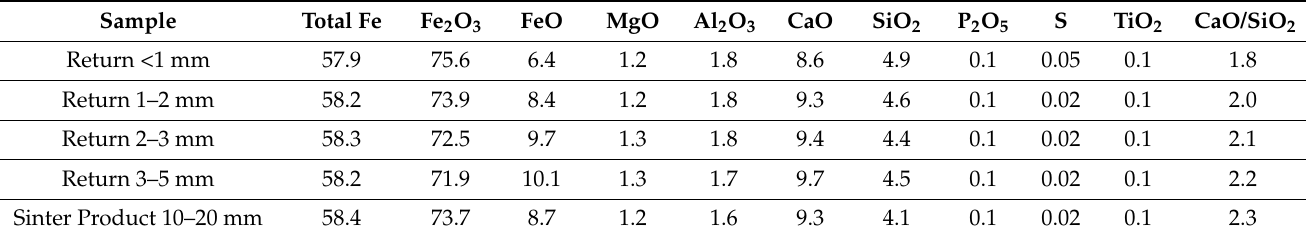
Table 1. Bulk compositions of the sinter samples (in wt%)